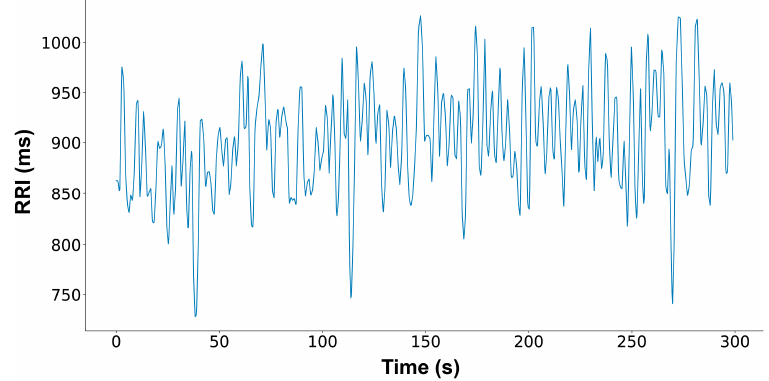
Figure 2. Sample 5 min RRI sequence from a subject from age group 1.